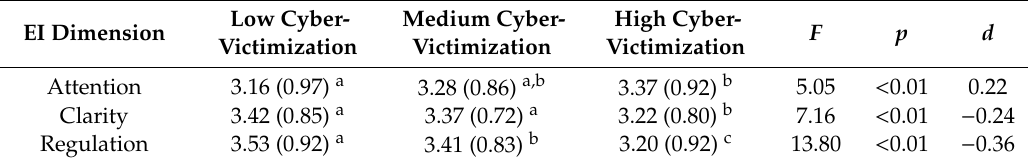
Table 2. Means, standard deviations (in parentheses), and results of the ANOVA of EI for the groups of Low, Medium, and High Cybervictimization.